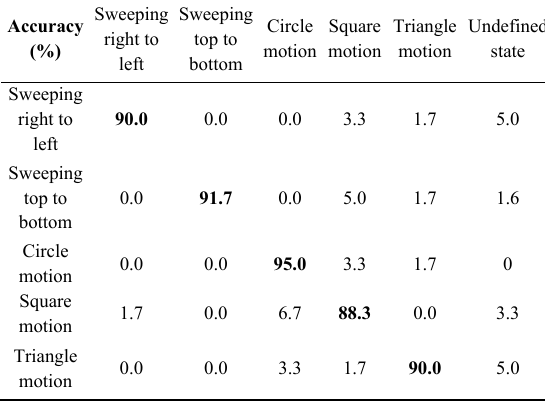
Table 3. Recognition result of hand movement gestures in